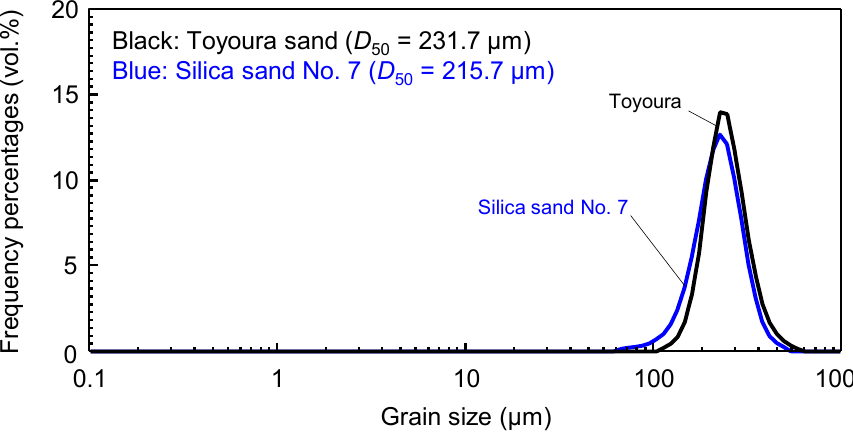
Figure 2. Grain size frequency distribution curves for Toyoura sand ( black ) and silica sand No. 7 ( blue )